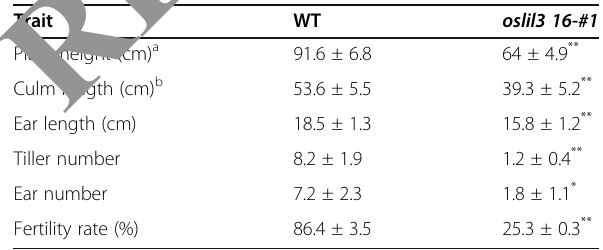
Table 1 Growth phenotypes and fertility rates of oslil3 vs WT. Trait WT oslil3 16-#1 Plant height (cm)